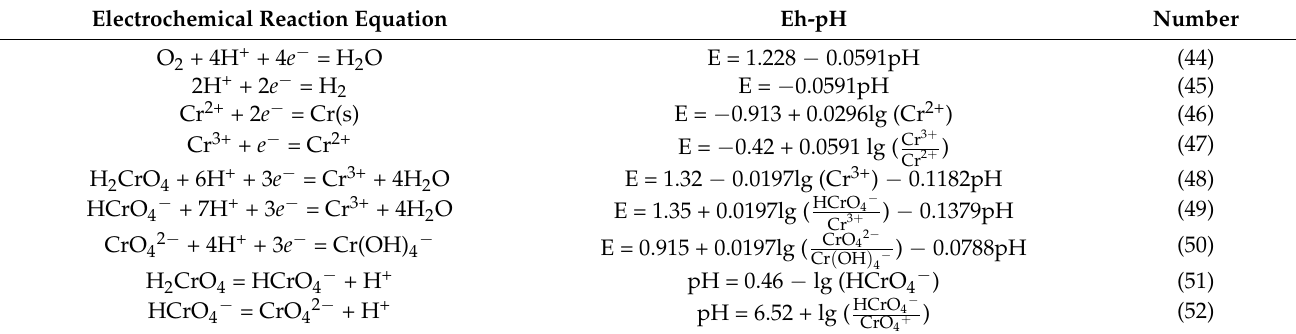
Table 3. Main electrochemical reaction equations of Cr-H 2 O system. Electrochemical Reaction